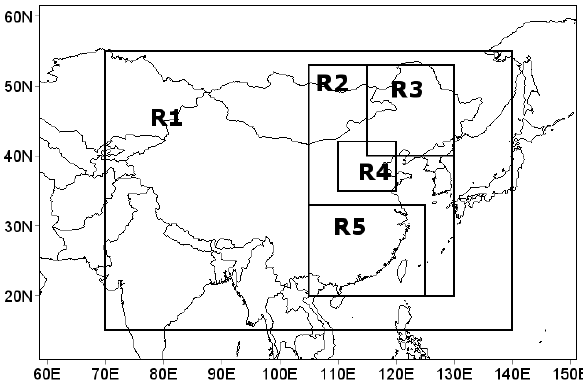
Figure 1. Model domain and five target areas. R1 encompasses the whole of China, R2 east China, R3 northeast China, R4 the North China Plain, and R5 encompasses south